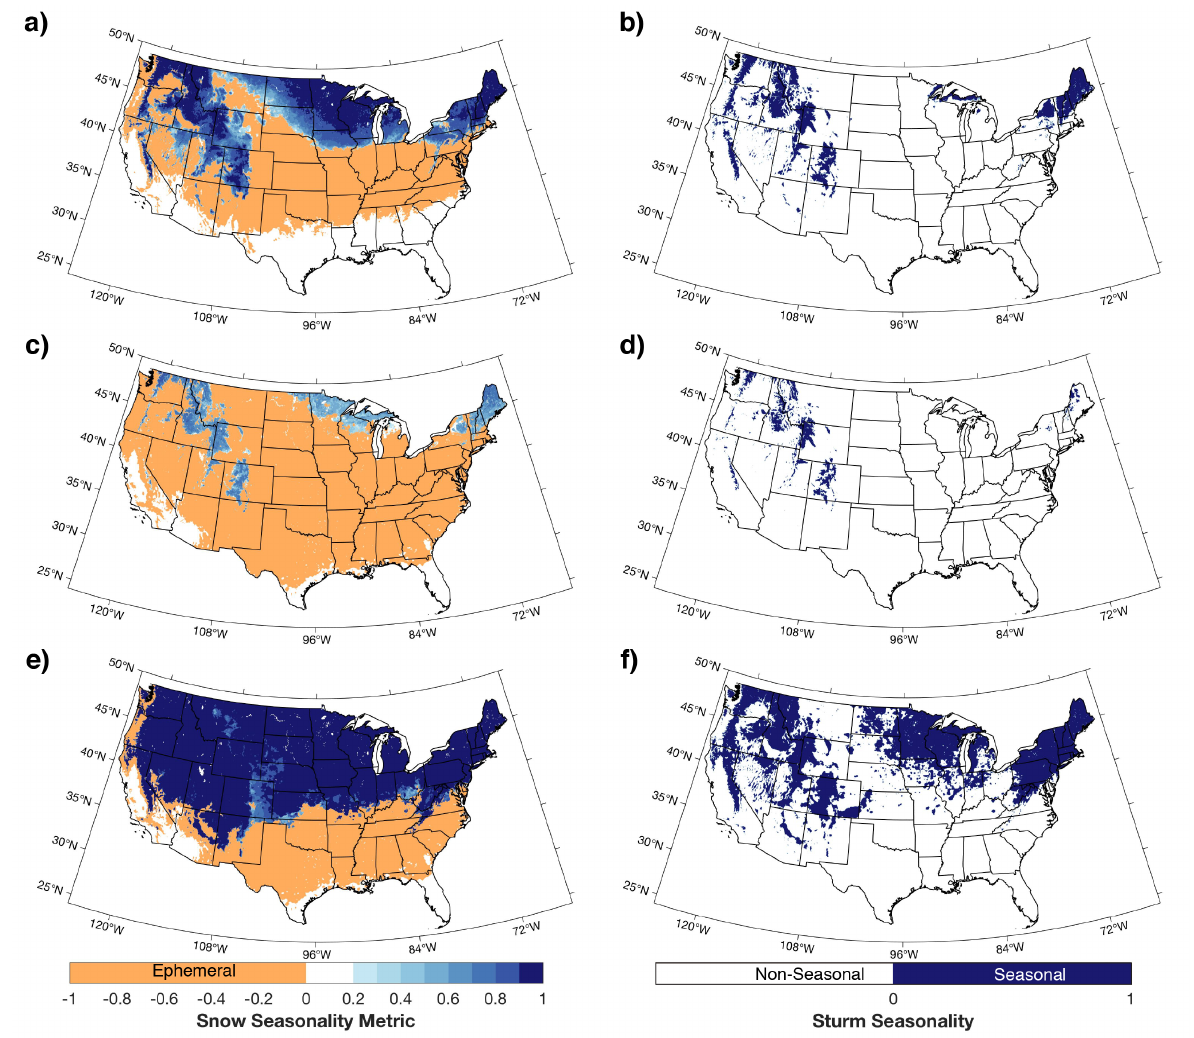
Figure 2. ( a ) Median snow seasonality metric (SSM). ( b ) Median Sturm seasonality. ( c ) Minimum snow seasonality metric. ( d ) Minimum Sturm seasonality. ( e ) Maximum extent of seasonal snow based on the snow seasonality metric. ( f ) Maximum extent of seasonal snow based on the Sturm